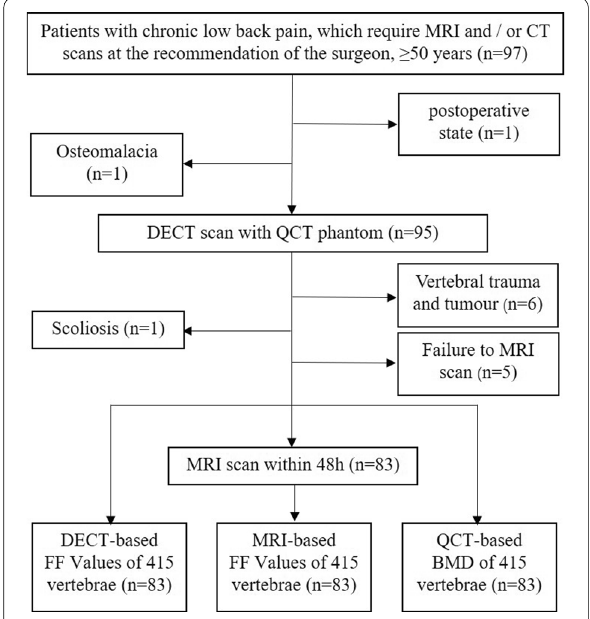
Fig. 1 The flowchart of the study. DECT Dual-energy computed tomography, QCT quantitative computed tomography, MRI magnetic resonance imaging, FF fat fraction, BMD bone mineral